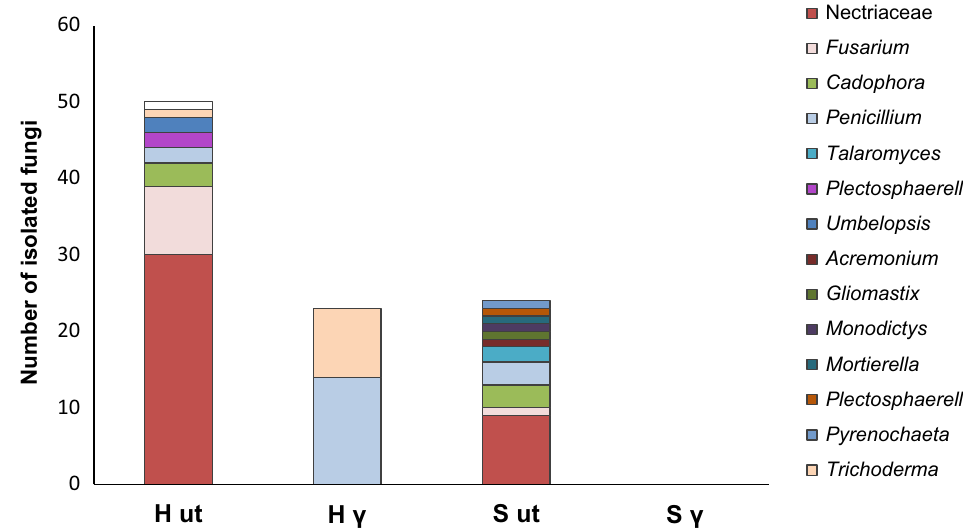
Figure 1. Fungal root endophytes isolated from surface disinfected roots of five R. corymbifera ’Laxa’ plants that were grown for 9 weeks in untreated (ut) or irradiated (γ) soils from replant diseased sites Heidgraben (H) and Sangerhausen (S), respectively (experiment 1). Number of isolates gained from 60 root segments per treatment, identified by ITS PCR and Sanger sequencing, and presented as family (Nectriaceae, exclusive Fusarium ) and as